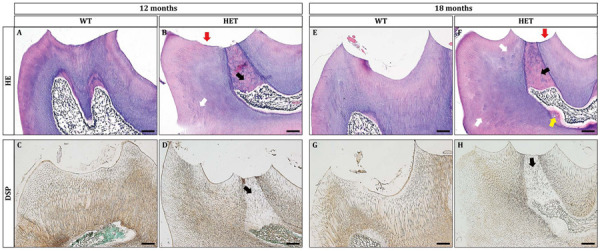
Dspp heterozygous mice exhibited dentin malformation at the ages of 12 months and 18 months. (A,B,E,F) HE staining showed that Dspp heterozygous mice (B,F) had aberrant reparative dentin (black arrows) beneath the attrited cusps (red arrows) or on the wall of the pulp chamber (yellow arrow). White arrows in (B,F) pointed to the hypomineralization in Dspp heterozygous mice. (C,D,G,H) DSP immunohistochemical staining. Sagittal sections of the crowns of the mandibular first molars were shown. The DSP positive signals in the dentin of the Dspp heterozygous mice (D,H) was relatively weaker than that in the WT mice (C,G). Reparative dentin showed much more weaker DSP than normal dentin [black arrows in (D) and (H)]. For each group, n = 3. Scale bars = 50 μm.